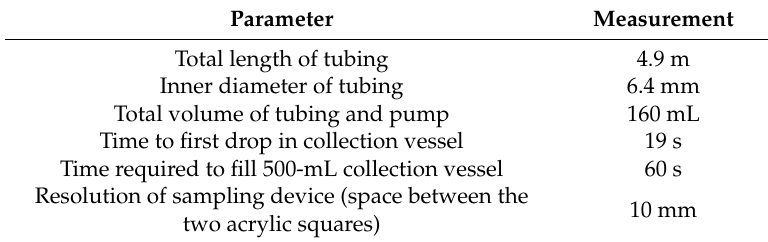
Table 2. Specifications and performance of the water sampler: Performance will vary based on the model of peristaltic pump used. The observations recorded here are specific to the use of a Global Water SP200 variable-speed pump driven by a 12 V